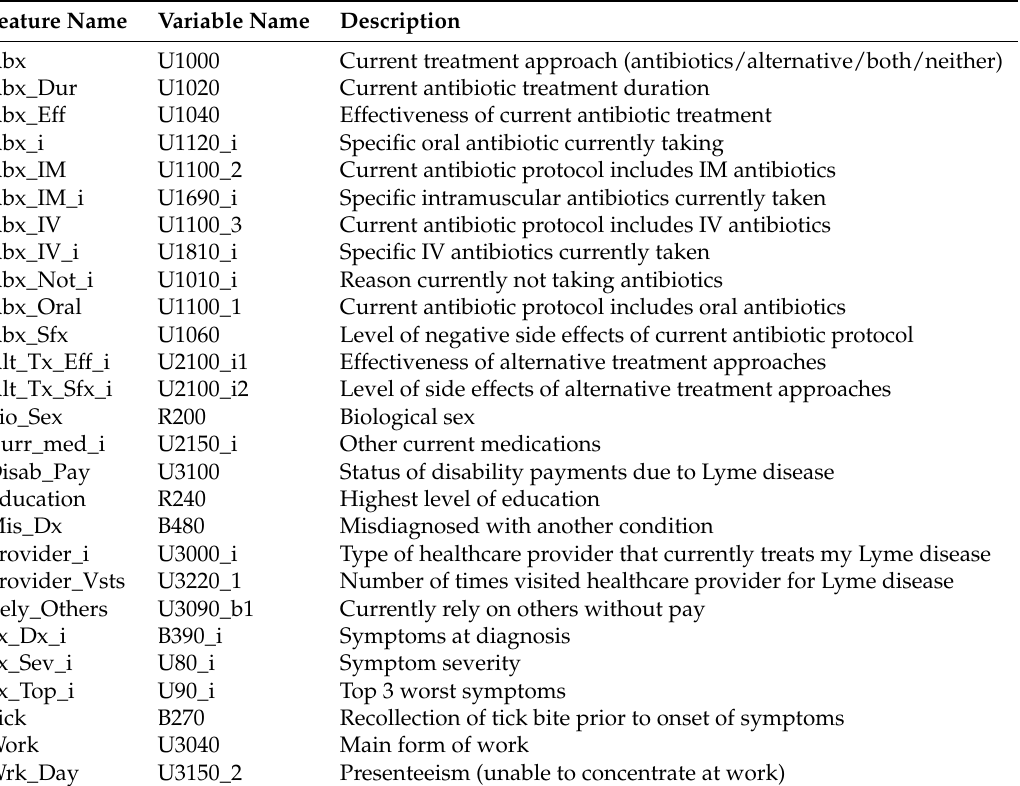
Table A1. Descriptions of relevant features. This includes all features mentioned in the paper. The Feature Name is the name used throughout the paper and the Variable Name is the original name used by the MyLymeData